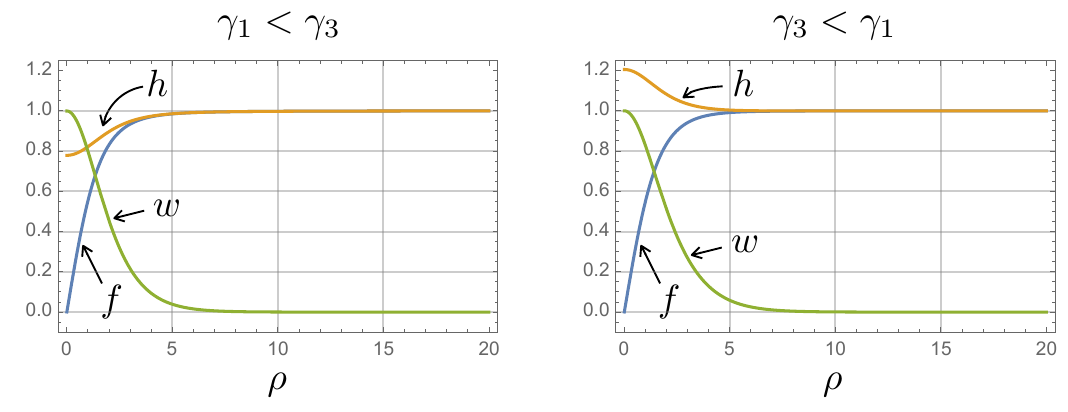
Figure 1 . The pro(cid:12)le functions of f ( r ), h ( r ) and w ( r ) for numerical solutions of an axially symmetric non-Abelian vortex string at the limit g 0 and the right one is for ( (cid:13) 1 ; (cid:13) 2 ) = (2 ; 1).